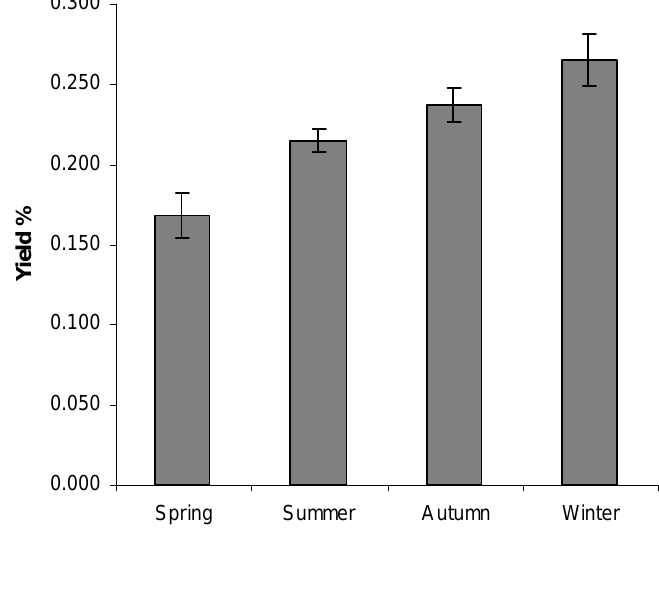
Figure 1. Yield of essential oils from fresh leaves of Tetradenia riparia collected monthly from September 2006 through August 2007, using Dunn's multiple comparison test (P =